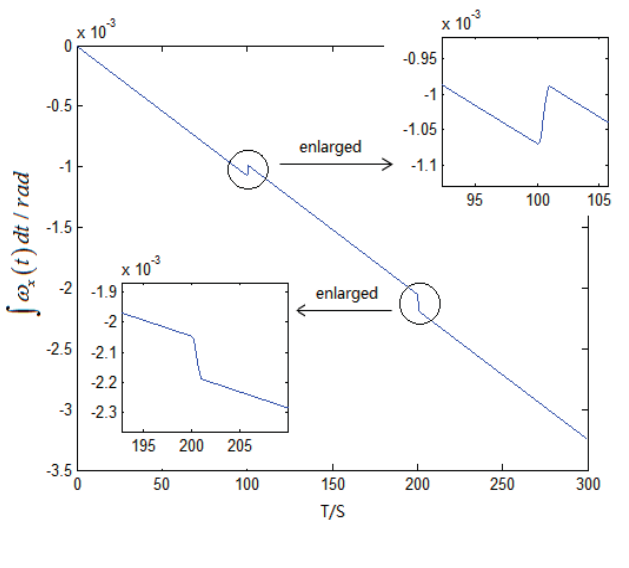
Figure 5. Variation